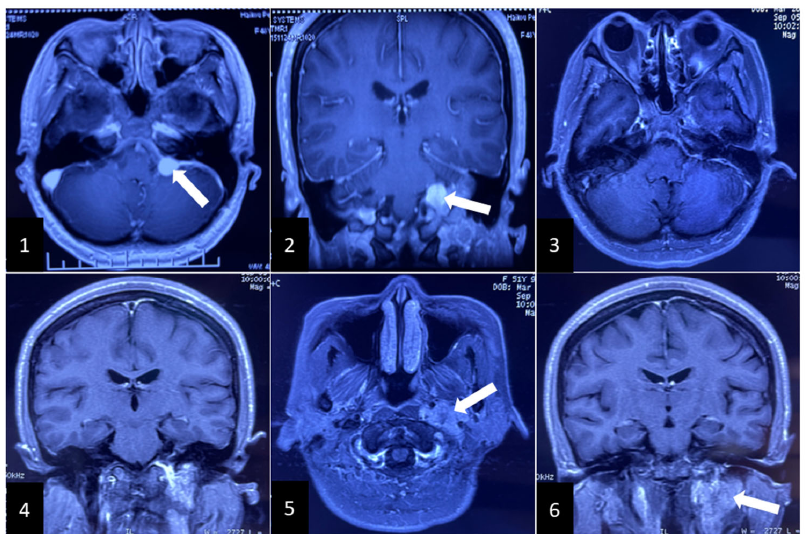
Figure 1. MRI and contrast-enhanced magnetic resonance images (CE-MRI) in the initial surgery. ( 1 ) and ( 2 ): displaying a highly enhanced intracranial lesion. White arrow: intracranial lesion; ( 3 ) and ( 4 ): presenting total resection of intracranial tumor; ( 5 ) and ( 6 ): revealing the residual extracranial lesion in the left jugular fossa and neck. White arrow: residual extracranial lesion.